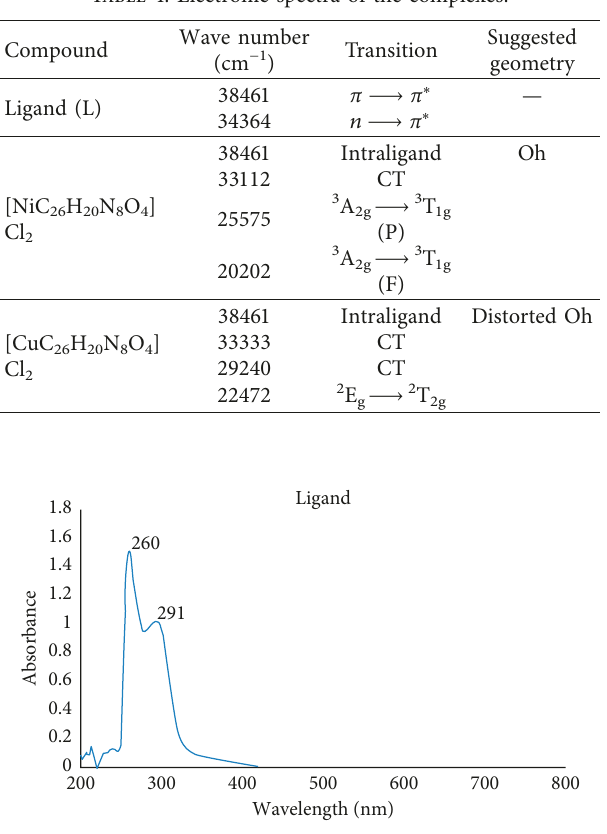
Figure 7: UV-visible spectrum of the